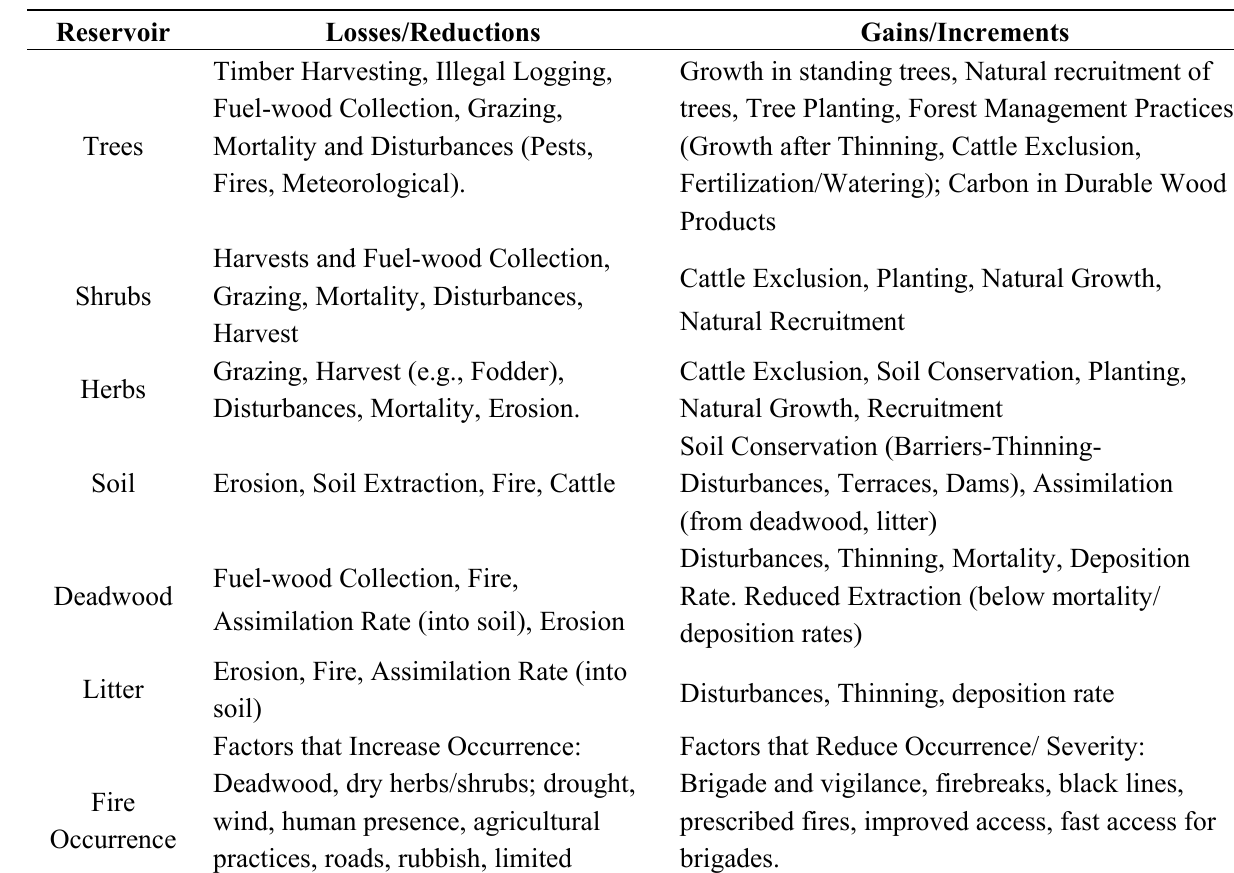
Table 2. Processes and activities associated to carbon reductions and increments for different